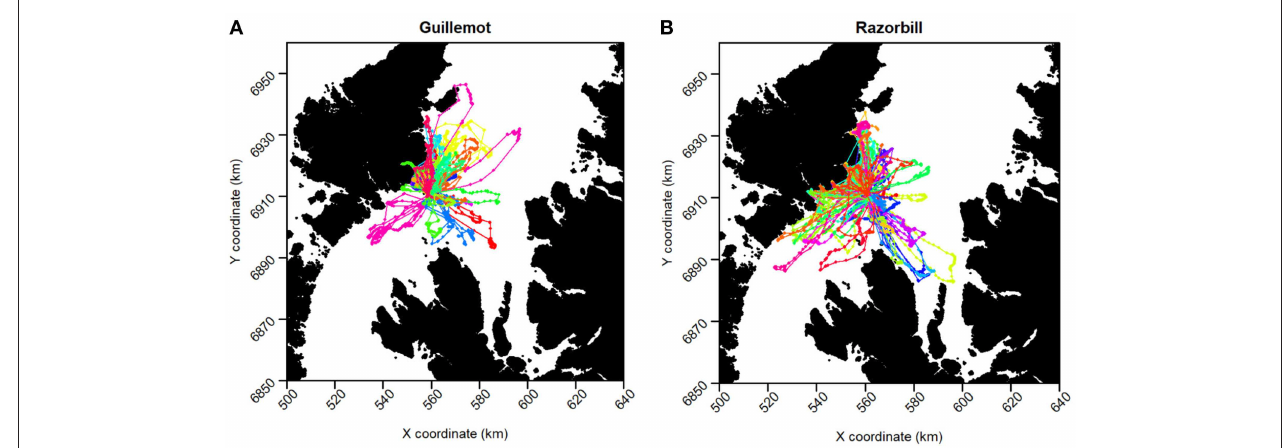
FIGURE 6 | Guillemot (A,B) and Razorbill (C,D) utilization distributions from boat surveys compared with concurrent GPS tracks. Darker reds indicate higher probability densities. Thick, dashed line indicates extent of 95% home range; thin, dotted line indicates extent of 50% home range.